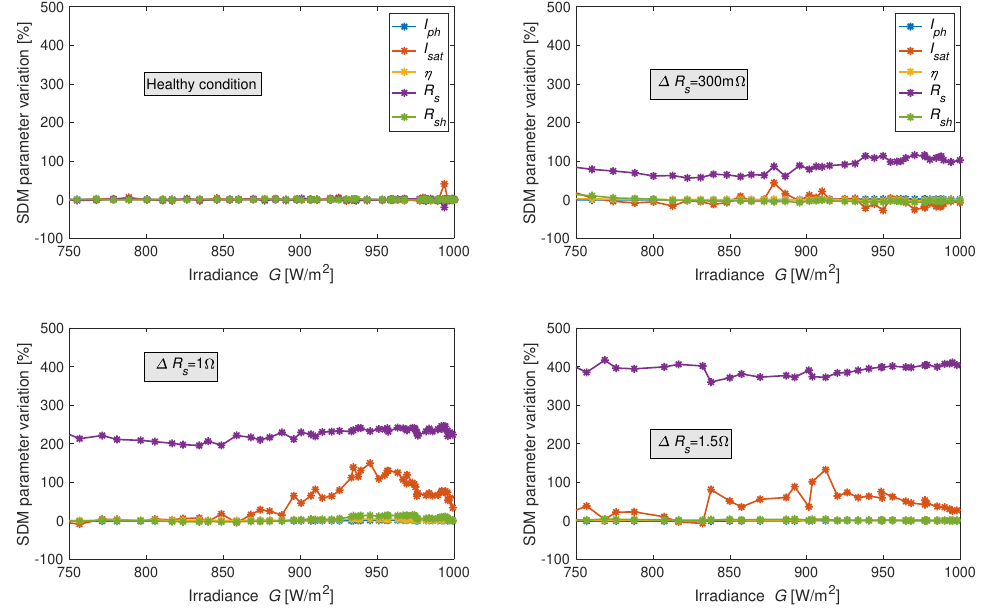
Figure 19. ANN identification of series resistance for different induced degradation effect and for different environmental